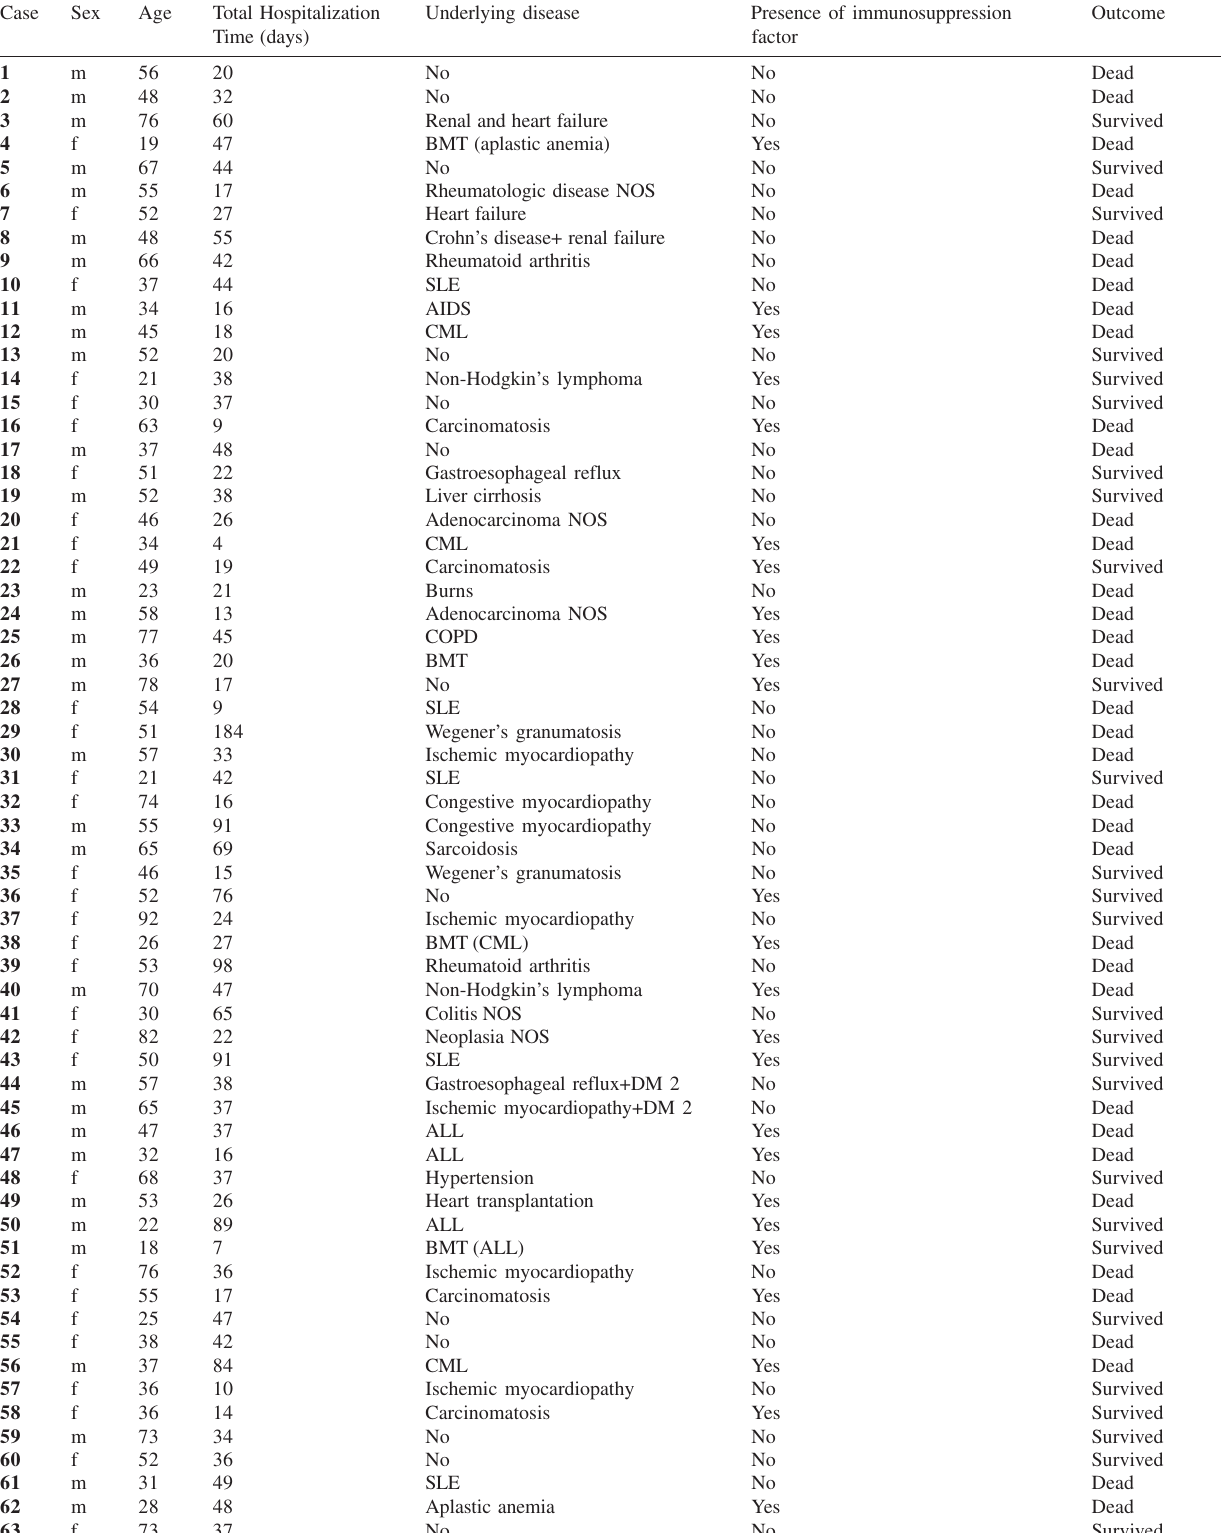
Table 1 - Epidemiological data of the 63 patients studied